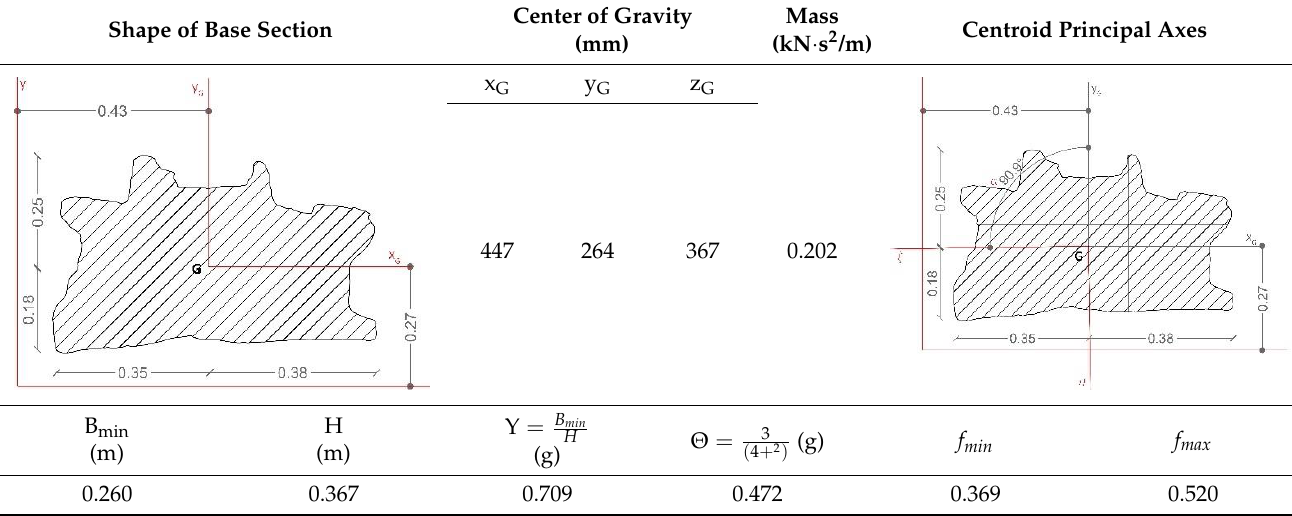
Table 4. Summary of the main geometric features of the asset for seismic rigid block Figure 12. Results of the seismic performance assessment of the Mater Matuta under horizontal shaking only. In more detail, each plot contains four lines: (i) the spectral acceleration at the site for rigid structures (T = 0) identified by a red line; (ii) the function Θ , representative of the horizontal acceleration level that triggers rocking motion in green; and the maximum (iii) and the minimum (iv) acceleration [..] thresholds associated to the sliding of the statue —